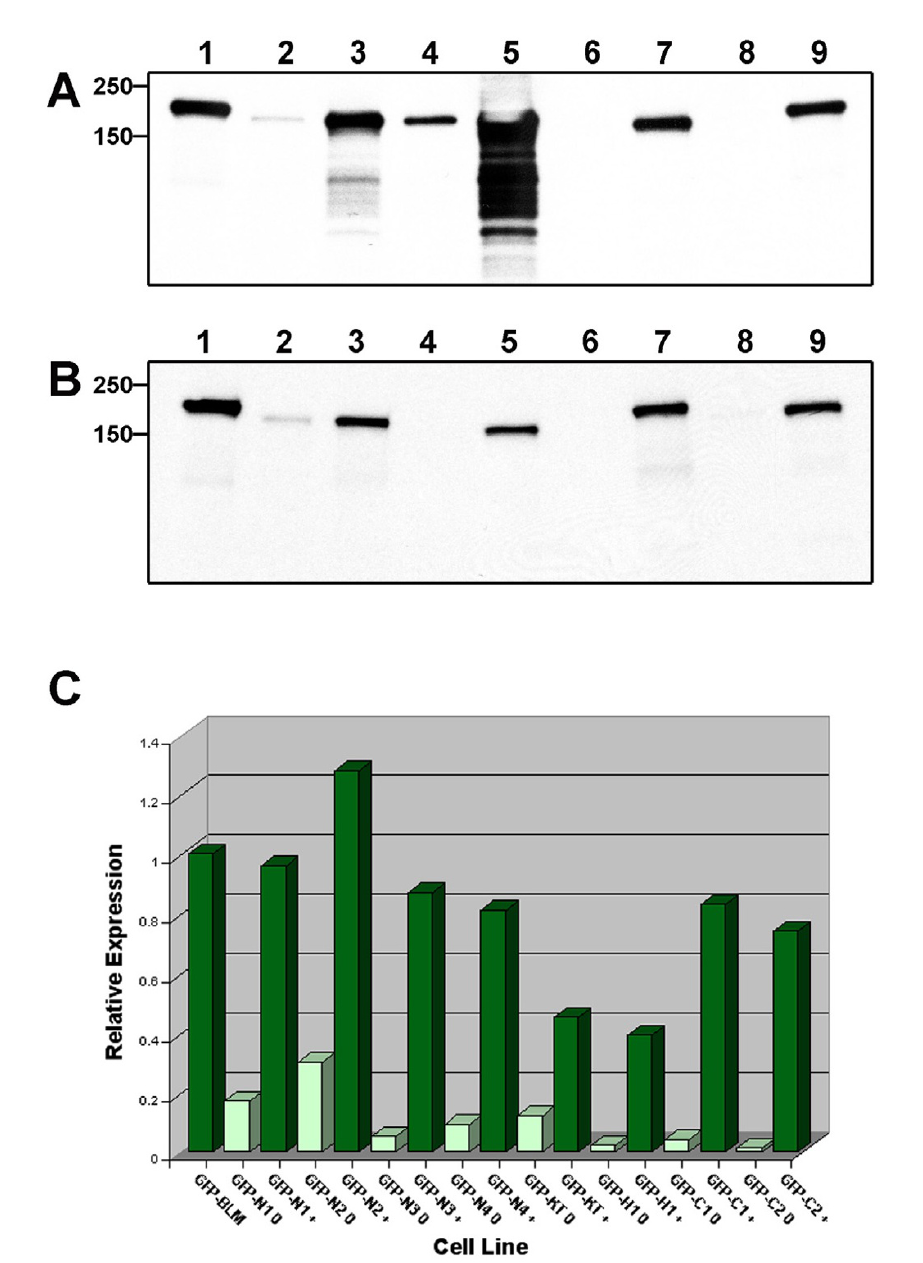
Figure 5 Western analysis of stable transfected cell lines expressing mutant BLM alleles. A. Whole cell lysates (15 µ g total protein) from uninduced and induced cells were resolved on 4-12% SDS polyacrylamide gels and transferred to PVDF mem- branes. The bound complexes were detected with ECL reagents and exposed to x-ray film: 1) GFP-BLM+Tet, 2) GFP- ∆ N1 no Tet, 3) GFP- ∆ N1+Tet, 4) GFP- ∆ N2 no Tet, 5) GFP- ∆ N2+Tet. 6) GFP- ∆ N3 no Tet, 7) GFP- ∆ N3+Tet, 8) GFP- ∆ N4 no Tet, 9) GFP- ∆ N4+Tet. B. ECL western analysis of whole cell lysates: 1) GFP-BLM+Tet, 2) GFP-K695T no Tet, 3) GFP-K695T+Tet, 4) GFP- ∆ H1 no Tet, 5) GFP- ∆ H1+Tet, 6) GFP- ∆ C1 no Tet, 7) GFP- ∆ C1+Tet, 8) GFP- ∆ C2 no Tet, 9) GFP- ∆ C2+Tet. The posi- tions of molecular weight standards are indicated to the left. Filters were reacted with α -GFP and goat α -mouse secondary conjugated with horseradish peroxidase. The bound complexes were detected with ECL reagents and exposure to x-ray film. C. Identical filters were reacted with α -GFP and goat α -mouse secondary conjugated with alkaline phosphatase. The fluores- cent ECF product was visualized with a Molecular Dynamics Storm. The fluorescent image was quantitated using Imagequant. The values were normalized to normal GFP-BLM